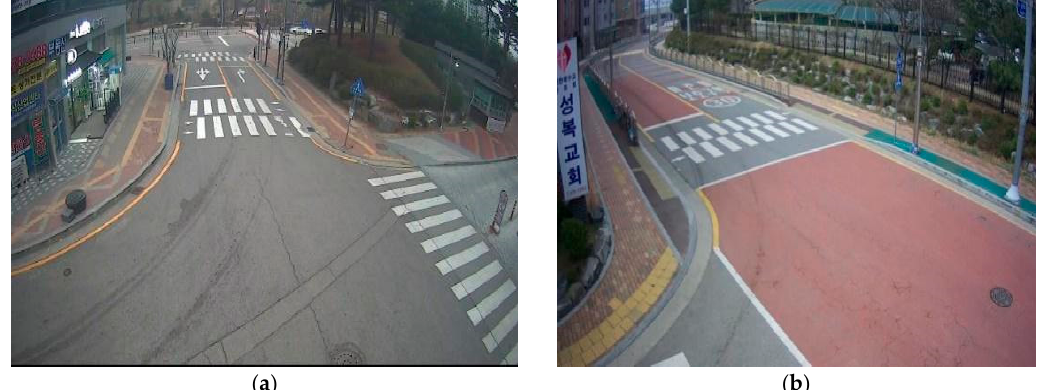
Figure 1. Closed-circuit television (CCTV) views in ( a ) spot A; and ( b ) spot B.